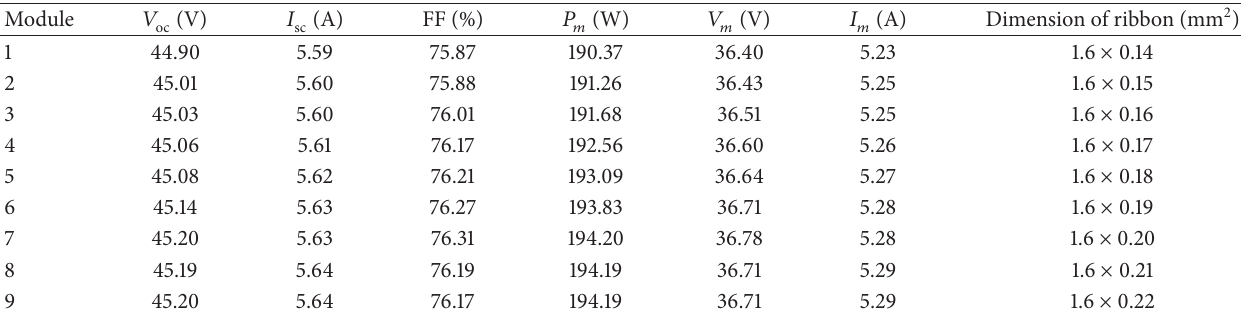
Table 4: The relationship between the power of solar module and thickness of ribbon.